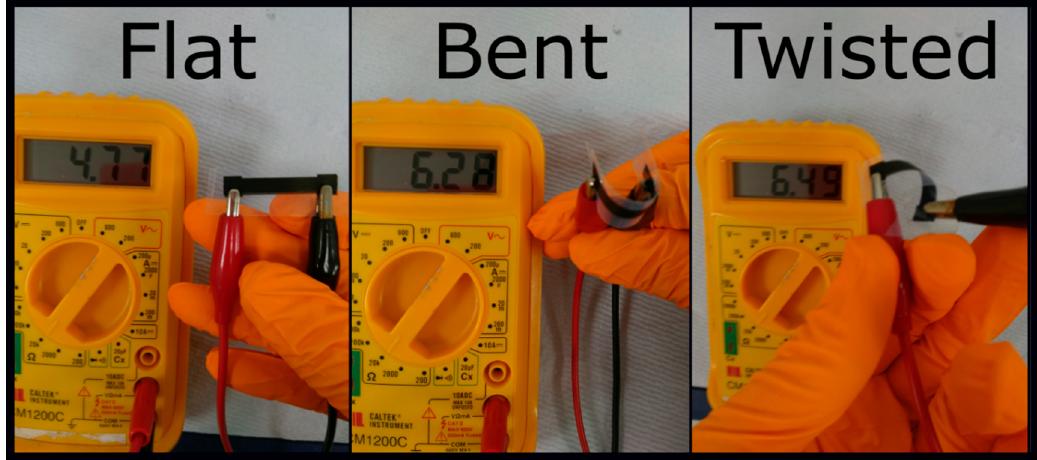
Figure A5. Conductive ribbons flat, bent, or even twisted.